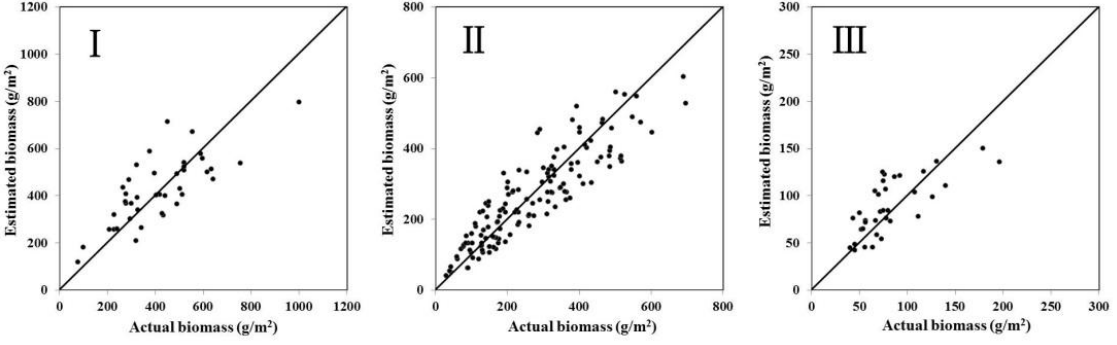
Figure 3. Relationship between the estimated and actual biomass values: Region I, Region II and Region III. The model precision for the relationship between the estimated biomass and the actual biomass was above